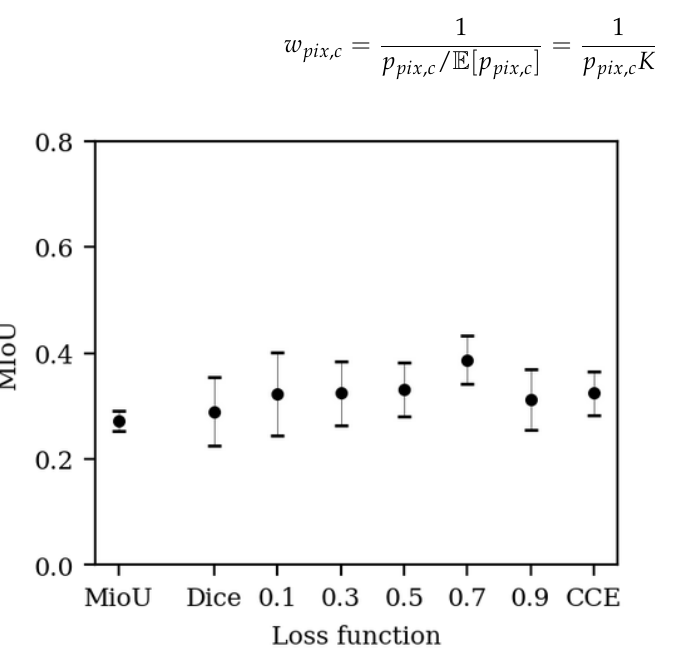
Figure 6. Mean intersection over union (mIoU) of the 1971 Sagalassos validation set for different loss functions. The numbers on the x -axis represent a weighted average between the dice loss and CCE loss ( α in Equation (9)). The average over five runs ( ± stdev) is shown, except for mIoU loss with only three